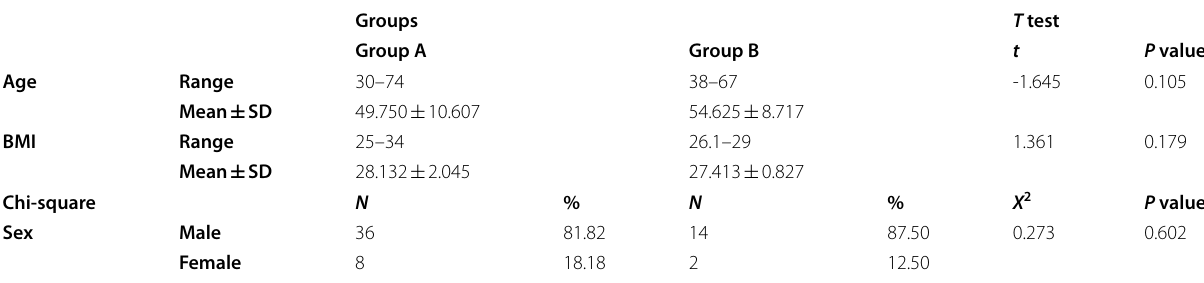
Table 1 Demographics and anthropometric data of the patients